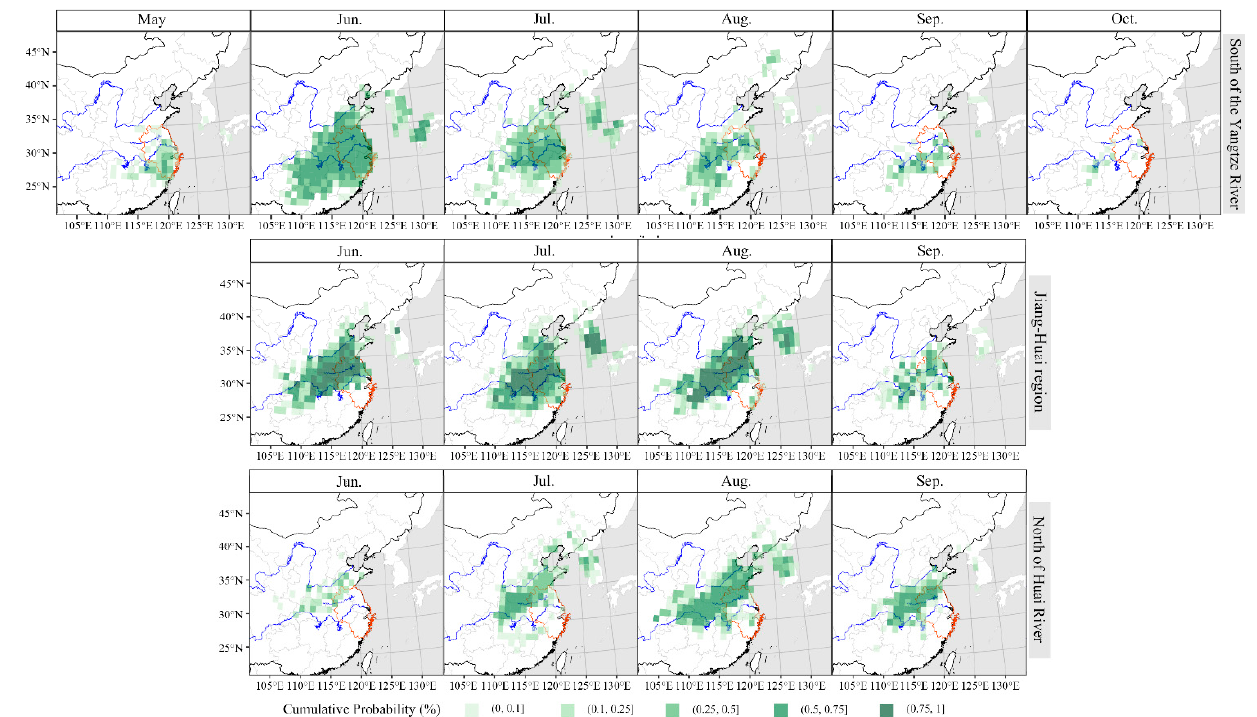
Figure 5. Forward trajectory endpoint distribution of Spodoptera frugiperda in the Yangtze River Delta from 2019 to 2021.